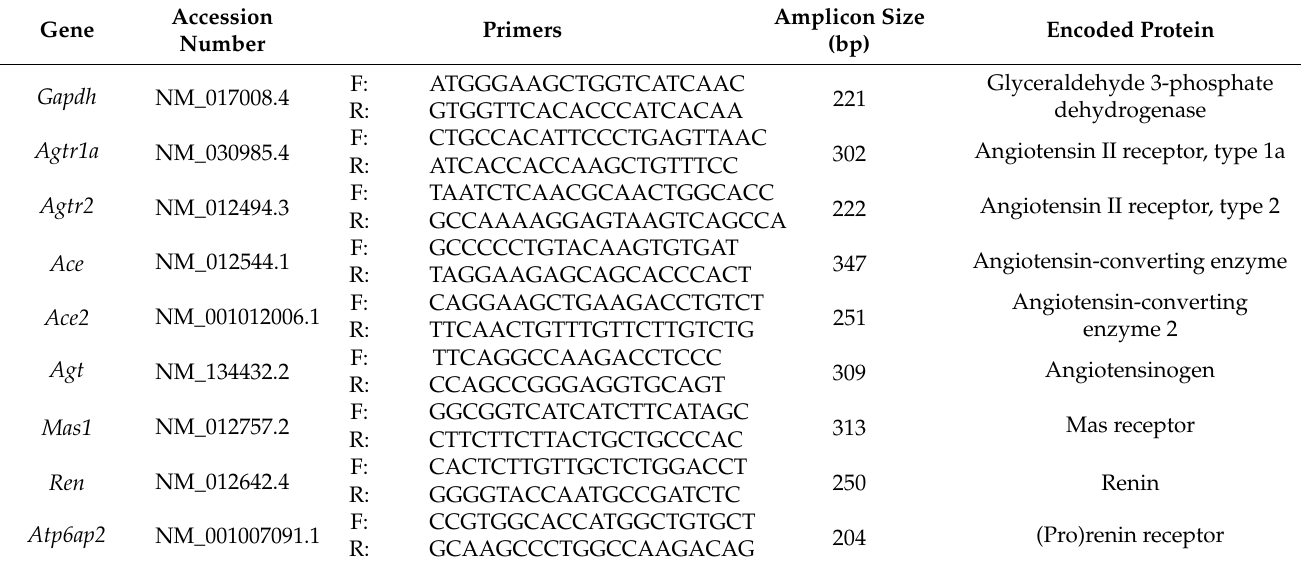
Table 2. Primer sequences and amplicon